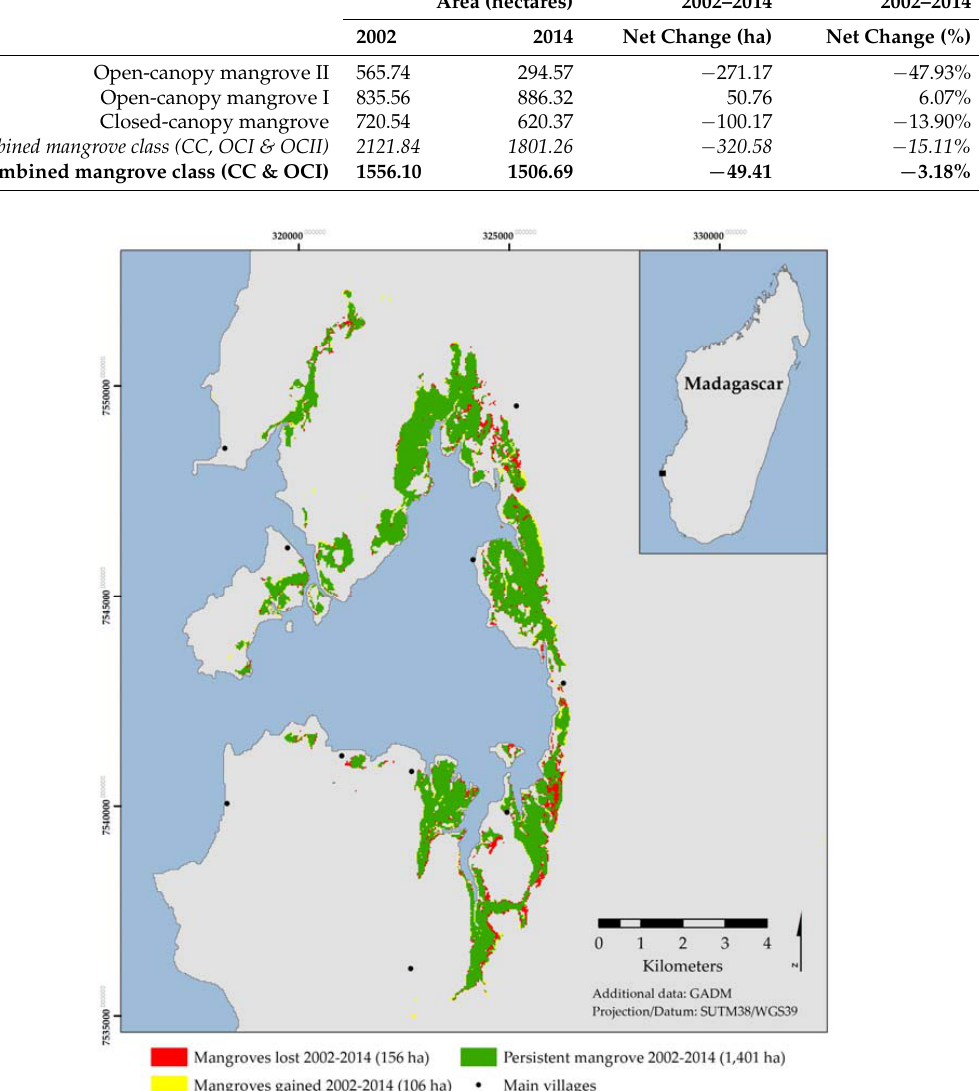
Figure 9. The spatial distribution of areas of mangrove loss, gain and persistence over the period